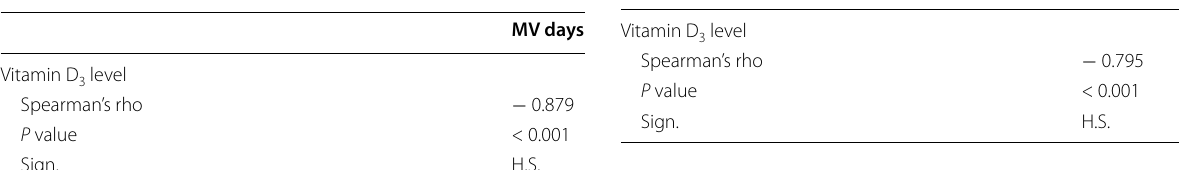
Table 3 Correlation between vitamin D